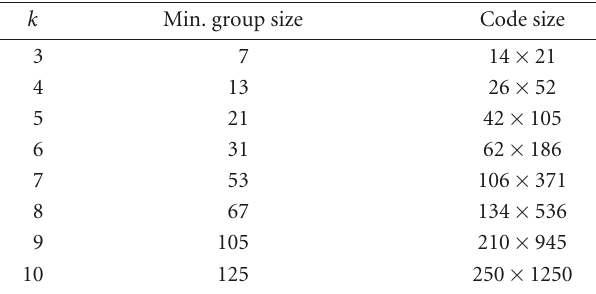
Table 2: ( N ,2, k ) girth-twelve codes using two groups and a ran- dom search.